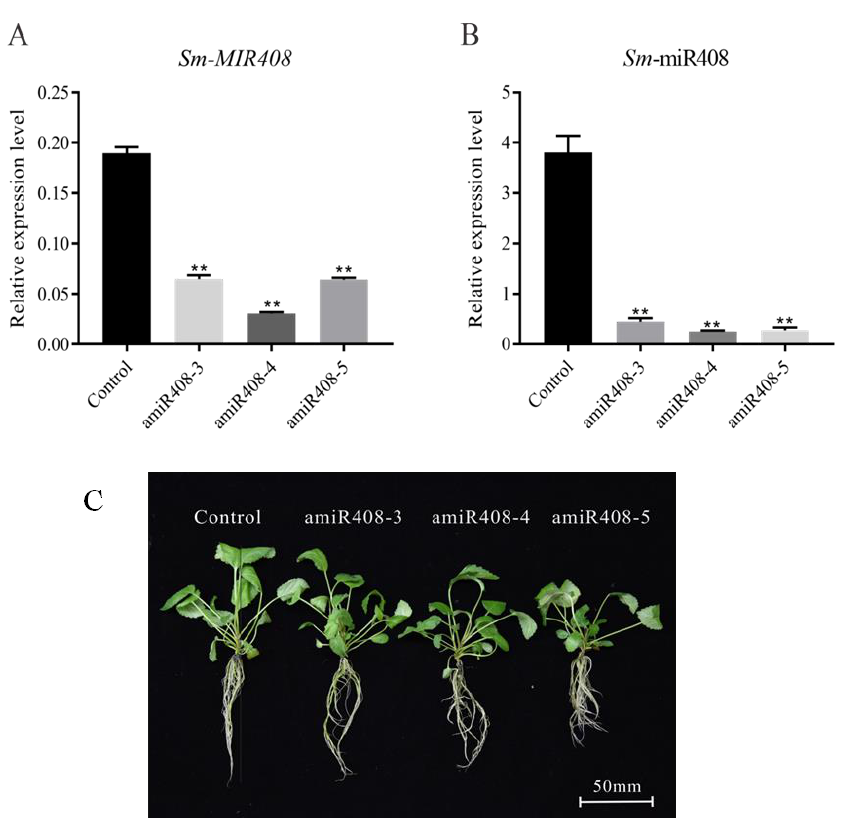
Figure 2. Identification and phenotype of the miR408-suppressed transgenic Salvia miltiorrhiza . ( A ) Expression level of the precursor miR408. ( B ) Expression level of mature miR408. ( C ) Phenotype of the miR408-suppressed transgenic lines (amiR408-3, amiR408-4, and amiR408-5) and the control. All data are means of three independent experiments, with error bars representing SD. Significant differences in comparison with the control were determined by Dunnett’s multiple comparison test (** p < 0.01).